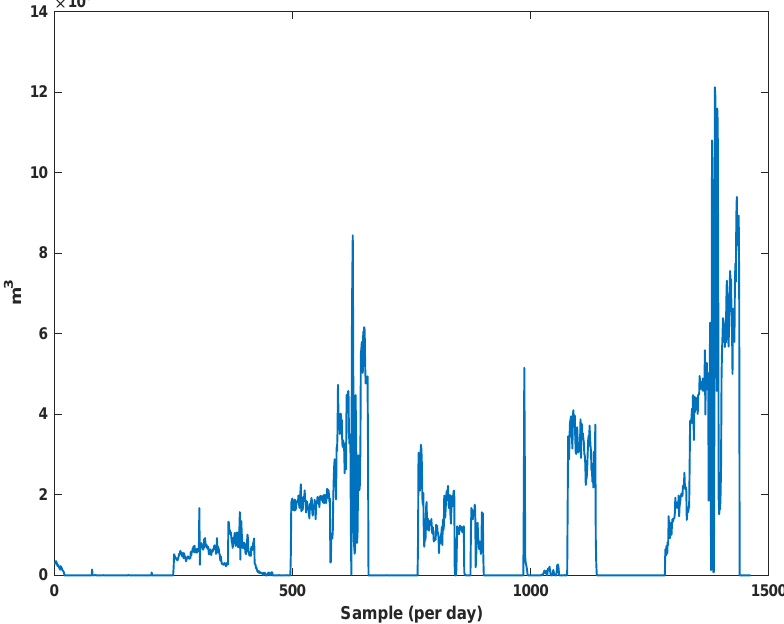
Figure 8. The trajectory of consumption line